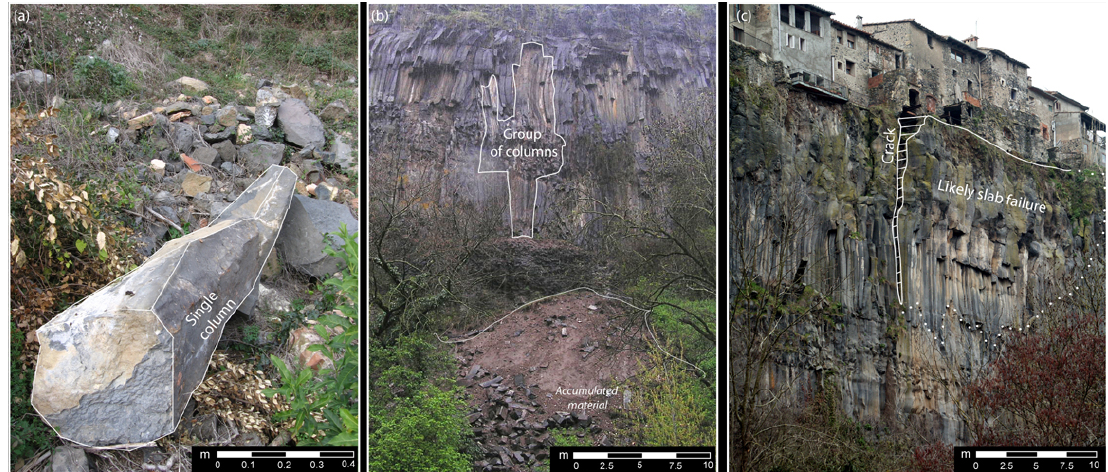
Fig. 2. Type of rockfall according to its volume: (a) detachment of single columns (volume below 1.5m 3 ); (b) detachment of a group of columns (volume from 1.5 to 150m 3 ); (c) likely slab failure (volume higher than 150m 3 ). The picture in Fig. 2b was taken by Llorenc¸